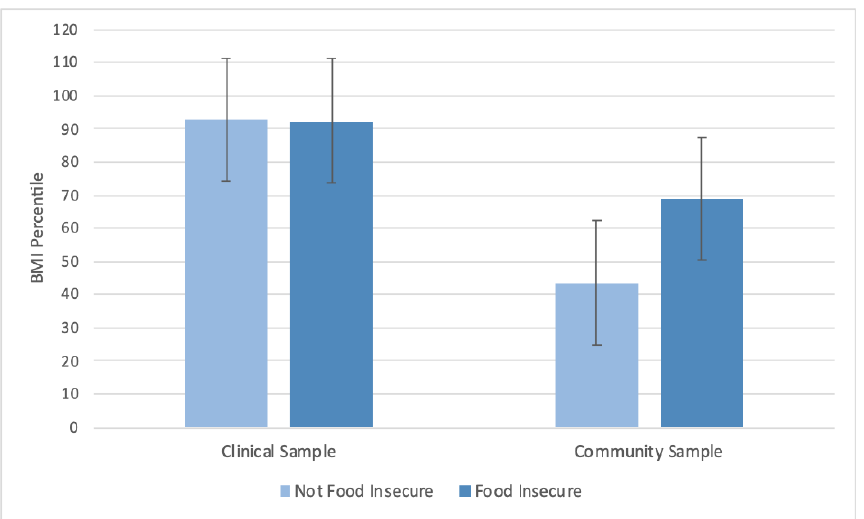
Figure 1. BMI percentile in clinical and community samples. p site < 0.01. p food insecurity = 0.02. p interaction = 0.02. Means ± SD are displayed.